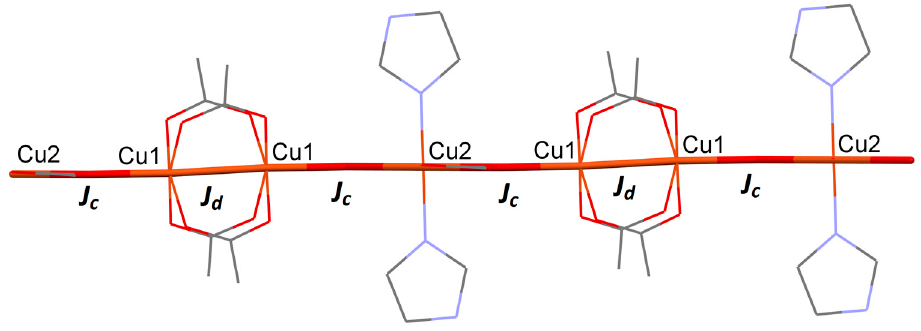
Figure 6. Wireframe and capped-stick representation of 1 , showing two possible superexchange pathways, with different coupling strengths ( J c and J d .).